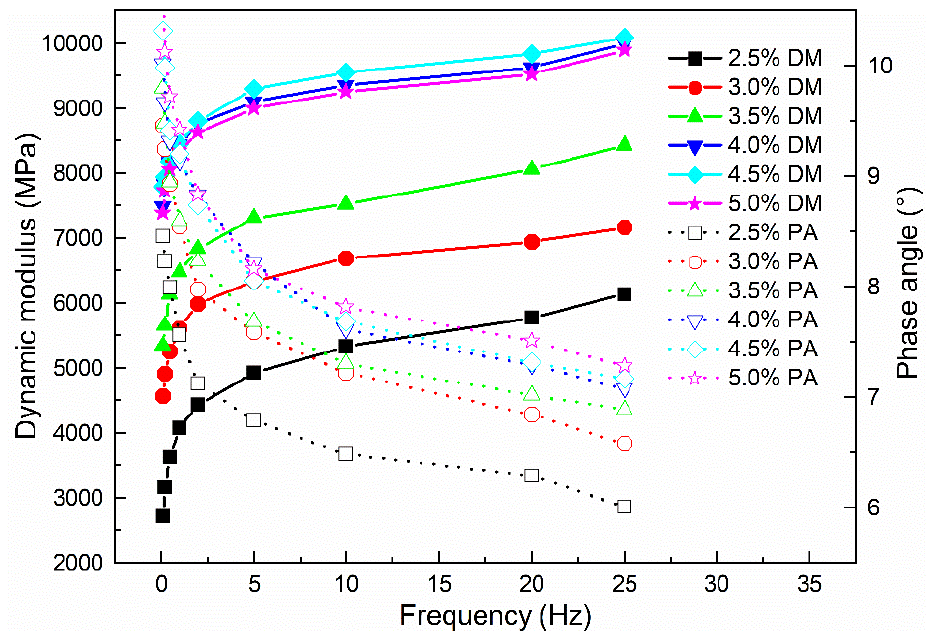
Figure 11. Influence of emulsified asphalt content on mechanical properties of CRAM.